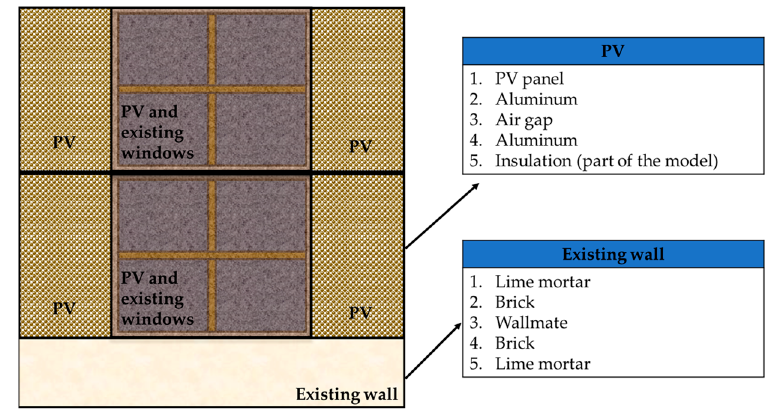
Figure 5. Formation of the Greek ADBE system.